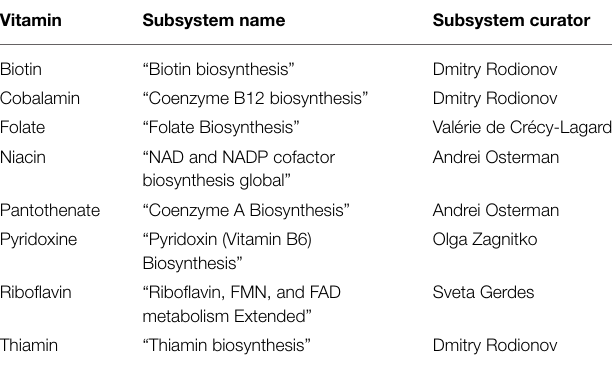
TABLE 1 | Subsystems analyzed for the studied